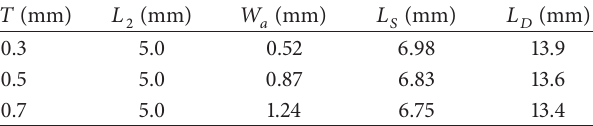
Figure 8: Cross-polarization far-field pattern with different sub- strate thicknesses. Table 2: Dimensions vary with the substrate